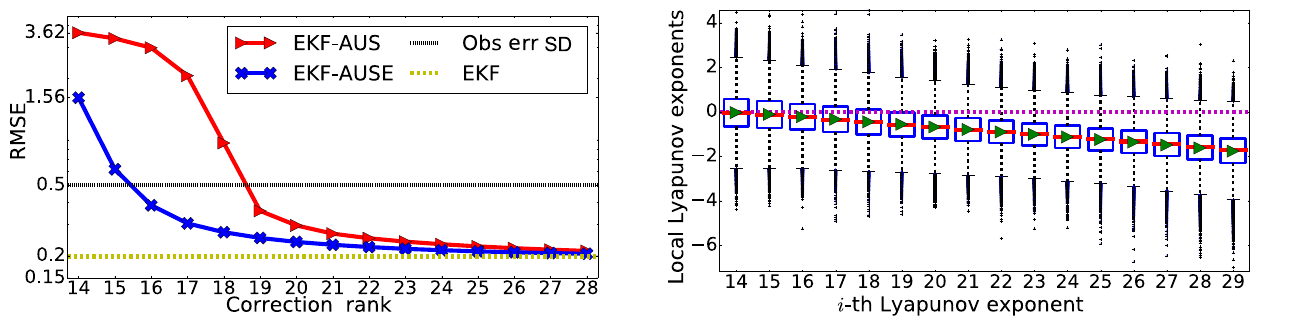
Figure 2. Analysis RMSE of EKF-AUS plotted with triangles and EKF-AUSE plotted with crosses, varying over the rank of the sub- optimal gain. Horizontal lines are the observation error standard deviation and the EKF analysis RMSE. Note the log scale of the y axis.